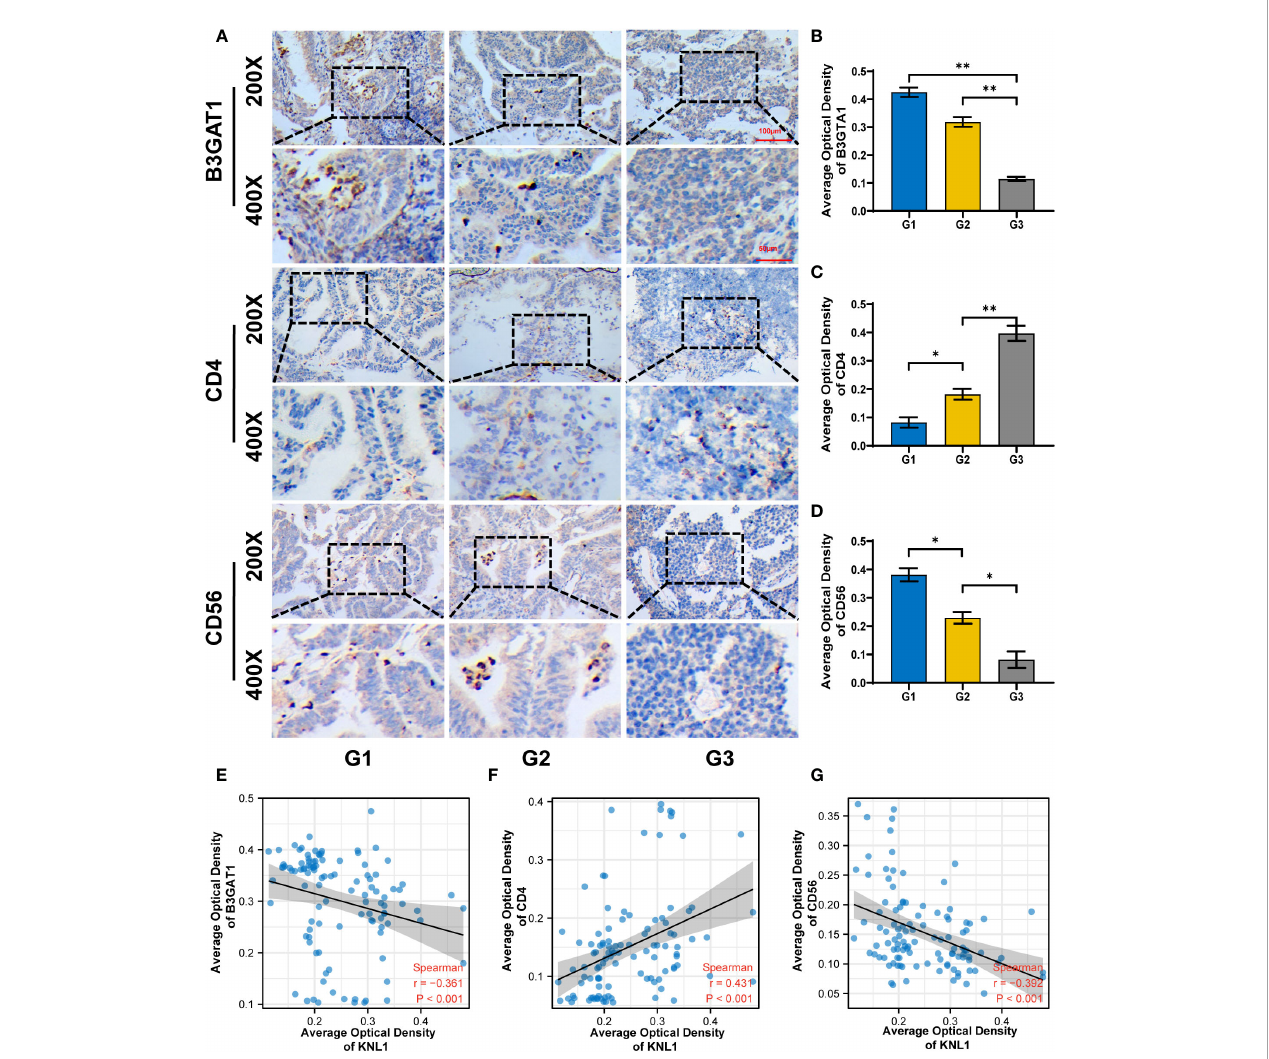
FIGURE 6 Correlation between KNL1 expression and the expression of CD4, CD56 and B3TAG1 in patients with UCEC. (A) Immunohistochemical images of CD4, CD56 and B4GAT1 in UCEC patients with different histologic grades. (B – D) Histogram of the immunohistochemical results for CD4, CD56, and B4GAT1. (E – G) Scatter plot of the correlation between the expression levels of CD4, CD56, and B3GAT1 and KNL1. Signi fi cance identi fi er:p ≥ 0.05; *, p< 0.05; **,